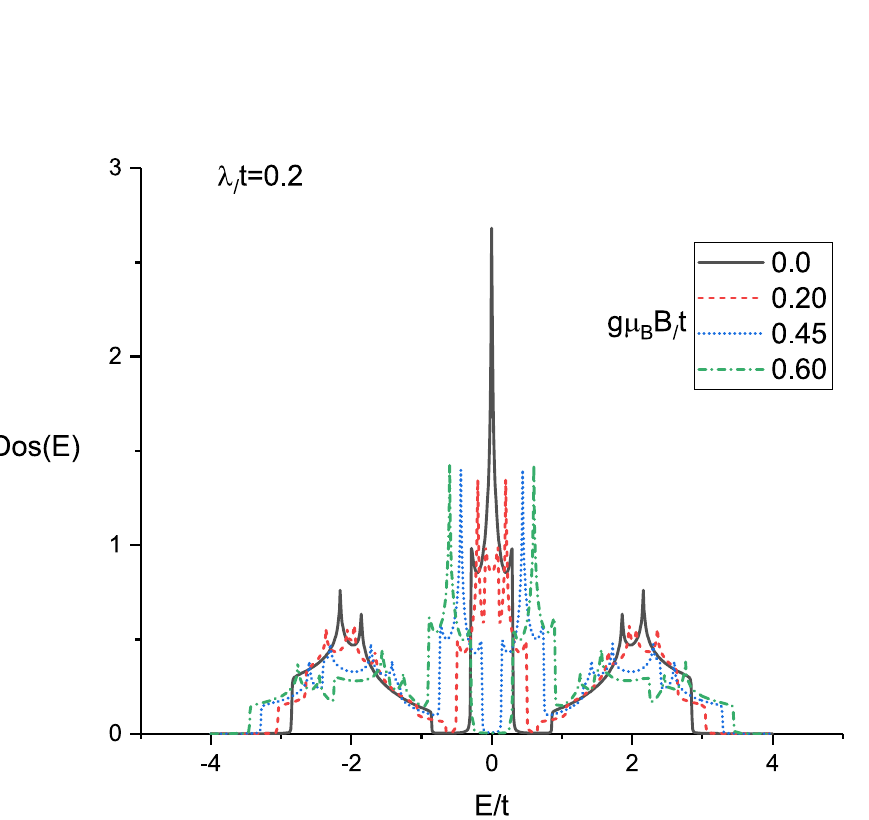
Figure 4. Density of states (DOS(E)) of electrons on Lieb lattice as a function of energy for different values of normalized magnetic field strength ,namely g µ B B / t = 0.0, 0.20, 0.45, 0.60 for (cid:31) / t = 0.2 at fixed gap parameter �/ t = 0.3